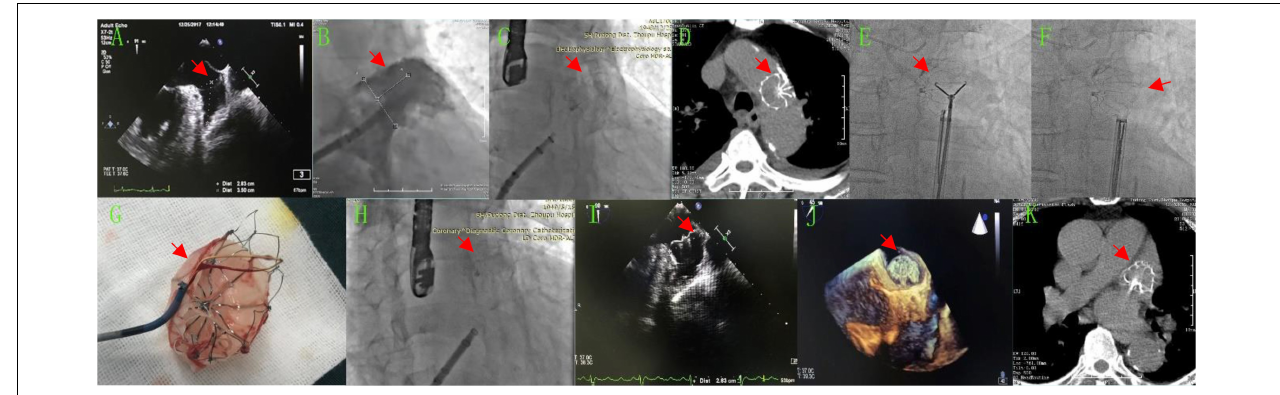
FIGURE 1 | After LAAC, the occluder fell off into the aortic arch and was feathered out, before the 33-mm Watchman device was occluded again. (A,I,J) LA TEE images. (A) Preoperative LAA: ostial of 25–30 mm and an effective depth of 28 mm. (I,J) Two-dimensional and 3-dimensional images after the second closure with the Watchman device. (B,C,E,F,H) DSA images. (B) Preoperative LAA with an opening of 28 mm and a depth of 31 mm. (C) After occlusion with the 33-mm Watchman device. (E,F) Endoscopic Raptor forceps were used to clamp the umbrella trabeculae and drag it into the sheath. (H) Second closure with the Watchman